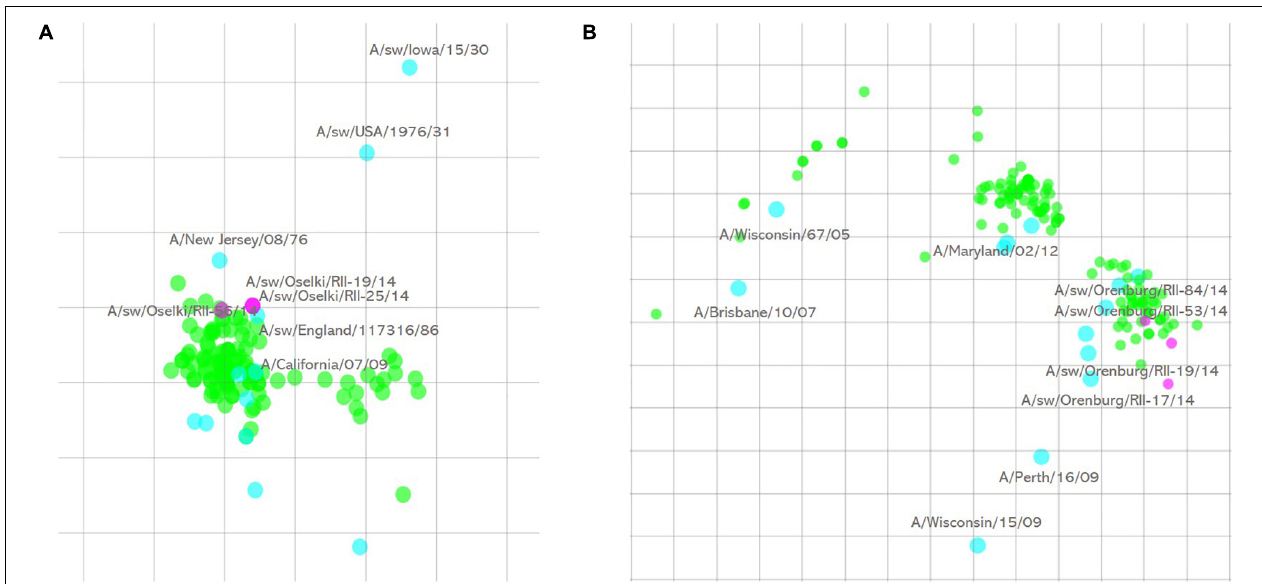
FIGURE 1 | Antigenic cartography of swine influenza A(H1N1)pdm09 (A) and influenza A(H3N2) (B) strains isolated in 2014. One square of the antigenic maps is equal to a twofold difference in HI titer. Green spheres—test antigens, cyan spheres—reference antigens, magenta—swine influenza strains isolated in this study.